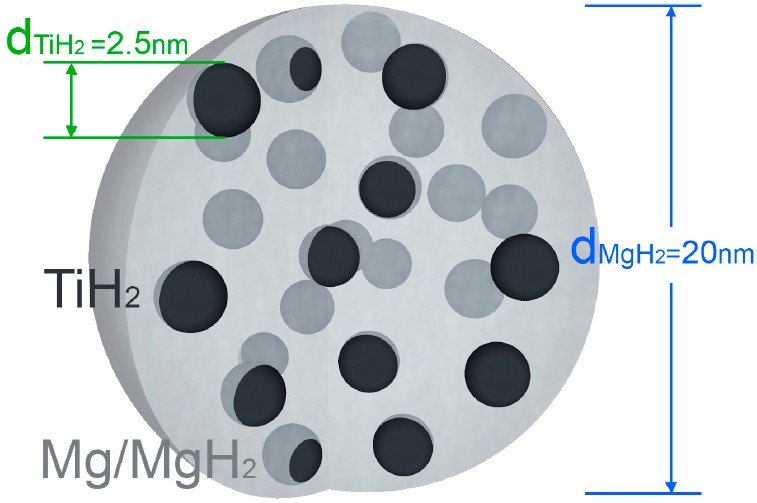
Figure 2. 3D model for MgH 2 –TiH 2 composite nanoparticles (NPs); d TiH TiH 2 and MgH 2 crystallite size.